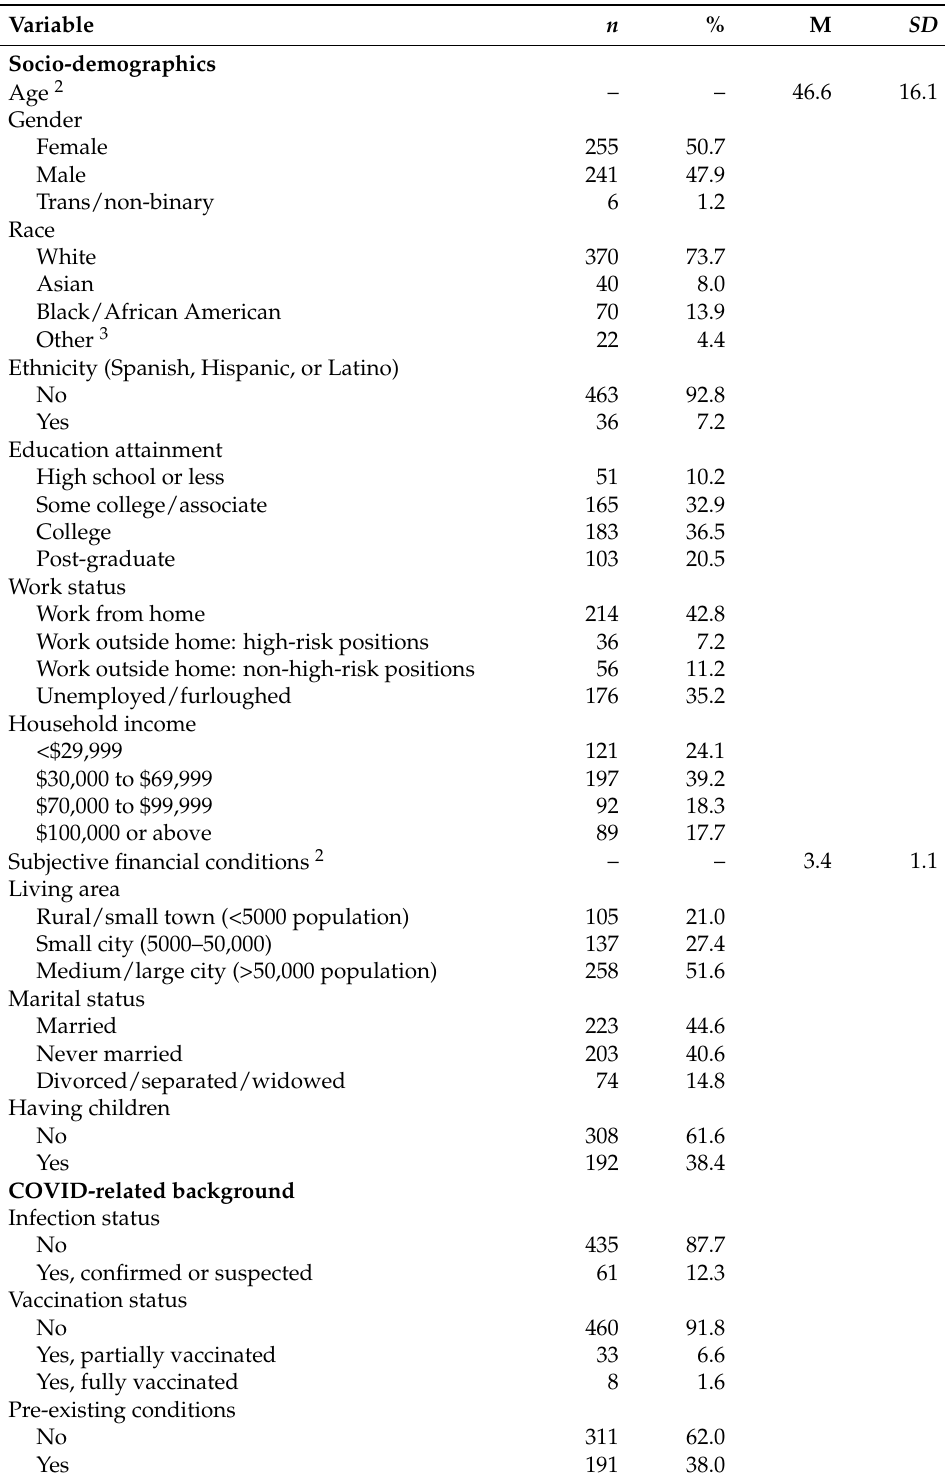
Table 1. Descriptive characteristics of socio-demographics and COVID-19 background variables ( n = 503) 1